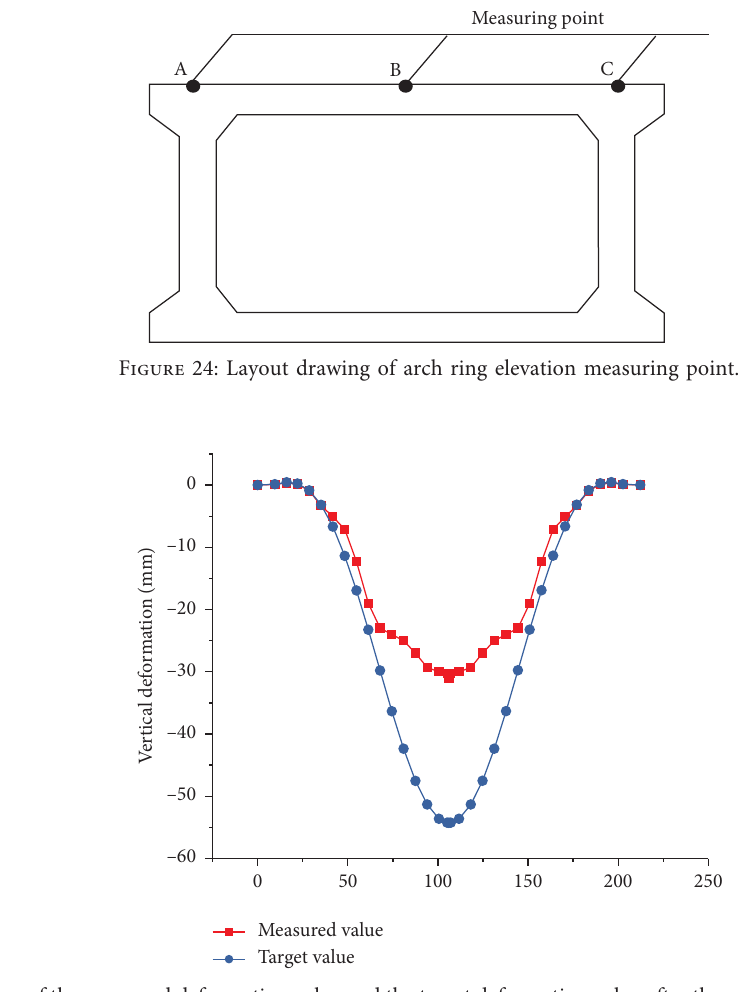
Figure 25: Comparison of the measured deformation value and the target deformation value after the arch ring construction is